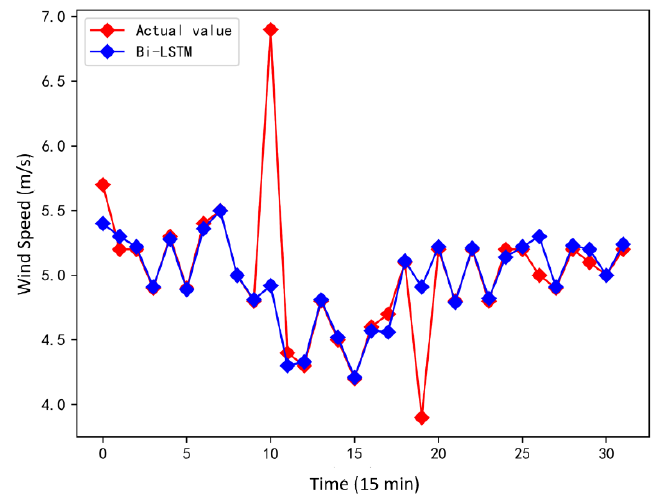
Figure 4. Sample result of EEMD ‐ BiLSTM Anomaly data detection for a wind turbine.